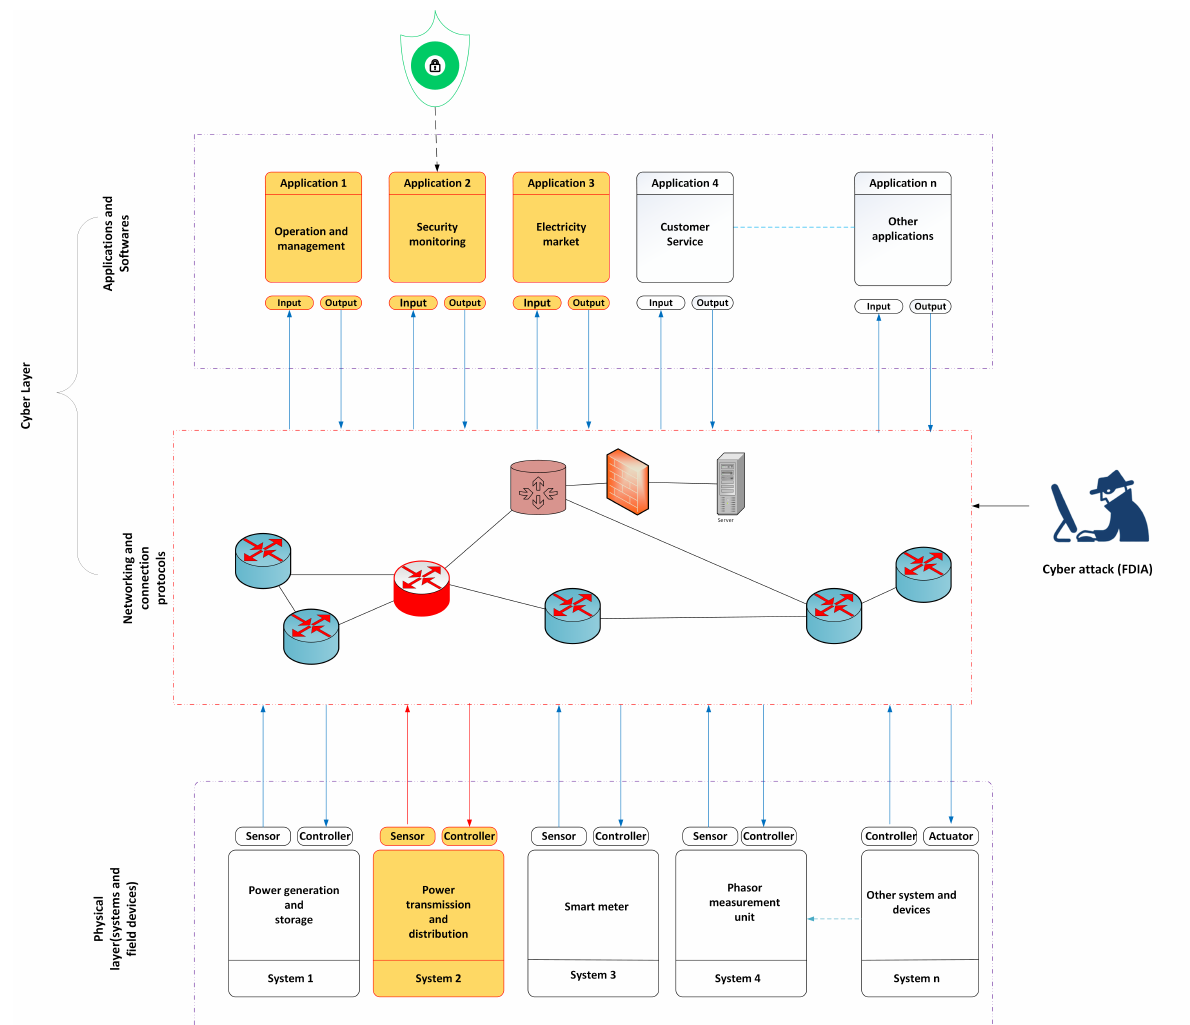
Figure 3. General illustration of false data injection attack in a smart grid